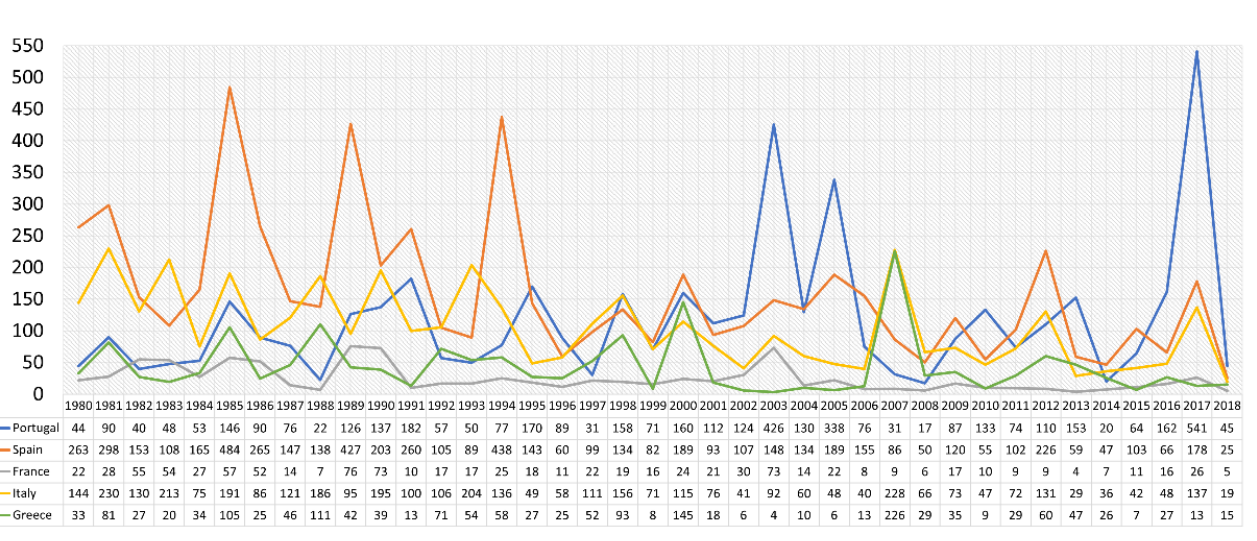
Figure A2. Fire weather schematics in which T (°C) is the air temperature, RH (%) is the relative humidity, W is the wind speed (km/h), and R (mm) is the rain (Adapted from Van Wagner [27]).